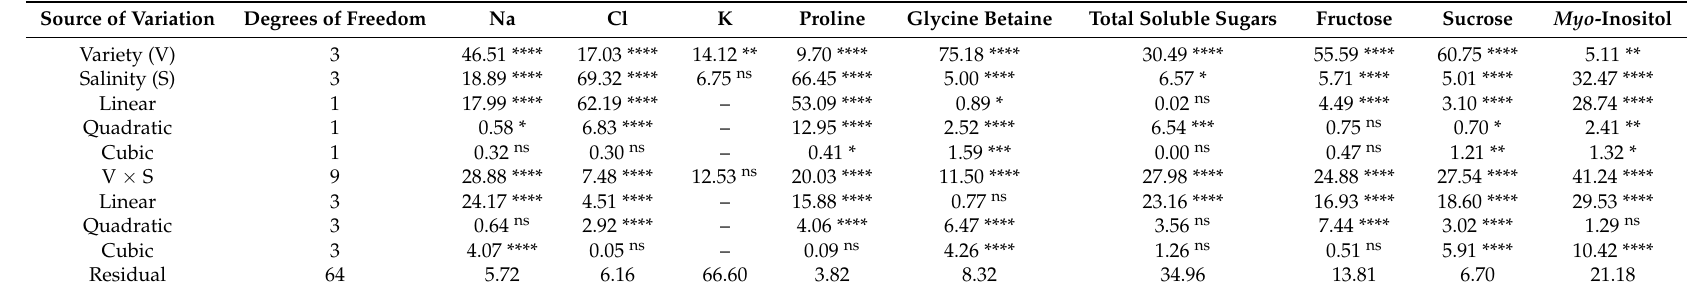
Table 3. Percentage of the total sum of squares for the effects of variety (V), salinity (S), and their interaction (V × S) for the ions, osmolytes, and carbohydrates contents in the leaves of plants of four Phaseolus varieties grown at four salinity levels (0, 50, 100, and 150 mM NaCl added to the medium solution). For the S and V × S sources of variation, the sum of squares has been decomposed in the linear, quadratic and cubic components. Source of